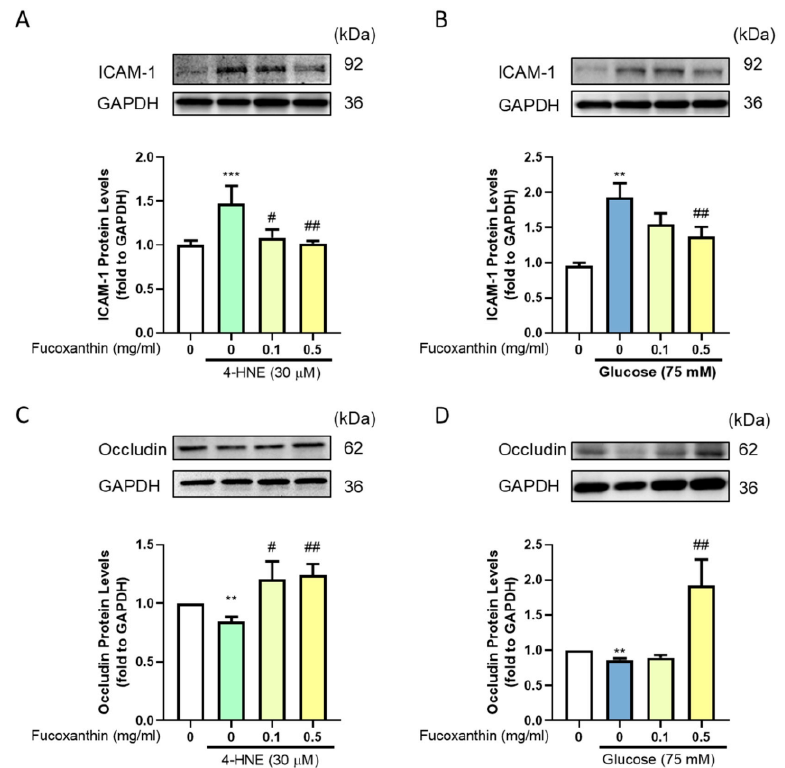
Figure 4. E ff ects of fucoxanthin on 4-HNE- and high glucose-induced ARPE19 blood–retinal barrier protein expression. ARPE19 cells were cultured in DMEM F12 for 24 h after serum free starvation for 18 h. This was combined with fucoxanthin induced by 30 µ M 4-hydroxynonenal (4-HNE) for 24 h or 75 mM glucose for 72 h. We used Western blotting to analyze the ( A , B ) ICAM-1 and ( C , D ) occludin protein expression ( n = 3). **, p < 0.01; and ***, p < 0.001 compared with the non-treated group. #, p < 0.05; and ##, p < 0.01 compared with the induced group (glucose 75 mM / 4-HNE 30 µ